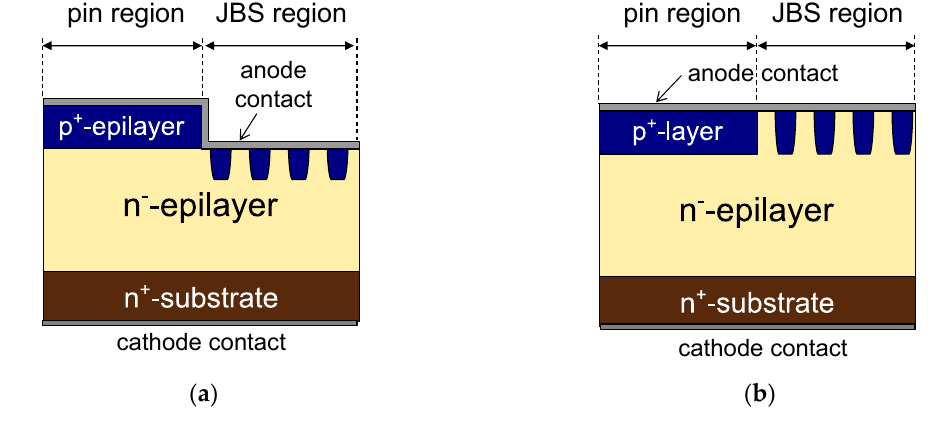
Figure 7. Schematic structures of SiC MPS diodes fabricated in this study. The main junction was formed by either ( a ) epitaxial growth or ( b ) Al + ion implantation. The widths of the pin and JBS (Junction-Barrier Schottky) regions were both 150 µm and of a stripe-like geometry. The active area was 3.6 × 10 − 3 cm 2 .